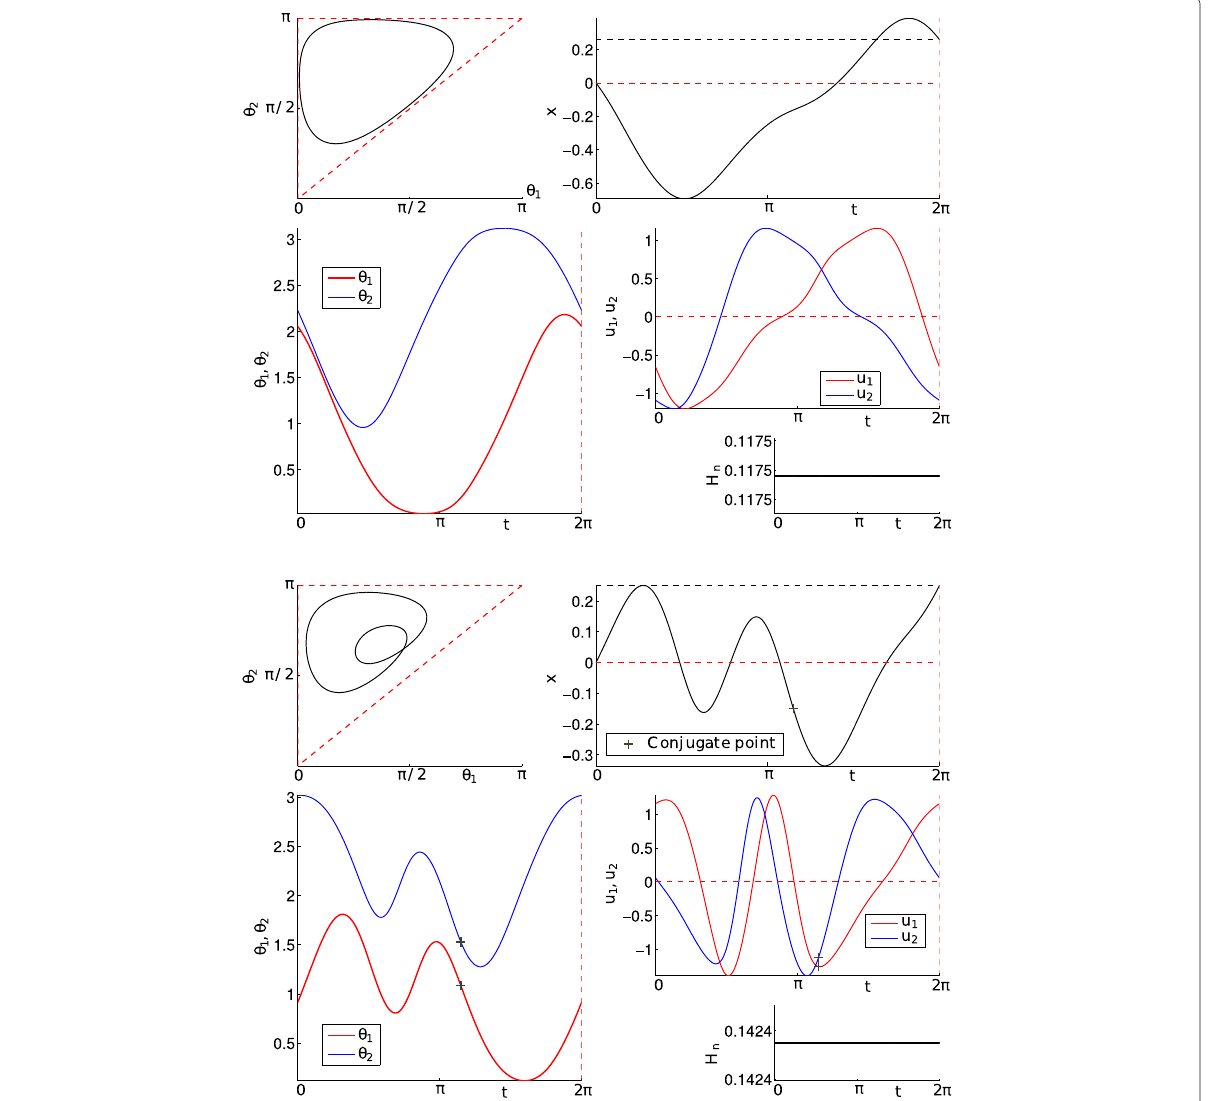
Fig. 11 Normal stroke where the constraints are satisfied: simple loop with no conjugate point on [0, T ] (top) and limaçon with inner loop with one conjugate point on [0, T ]